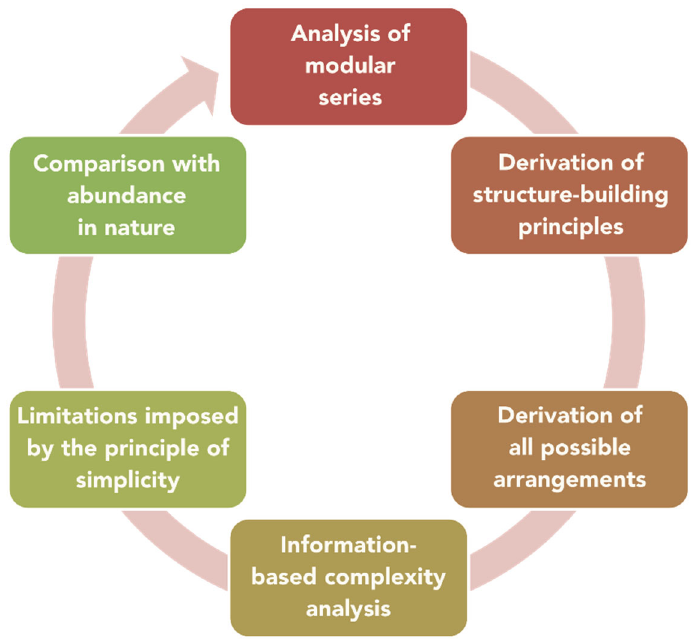
Figure 1. The complexity analysis of modular series of inorganic crystal structures.